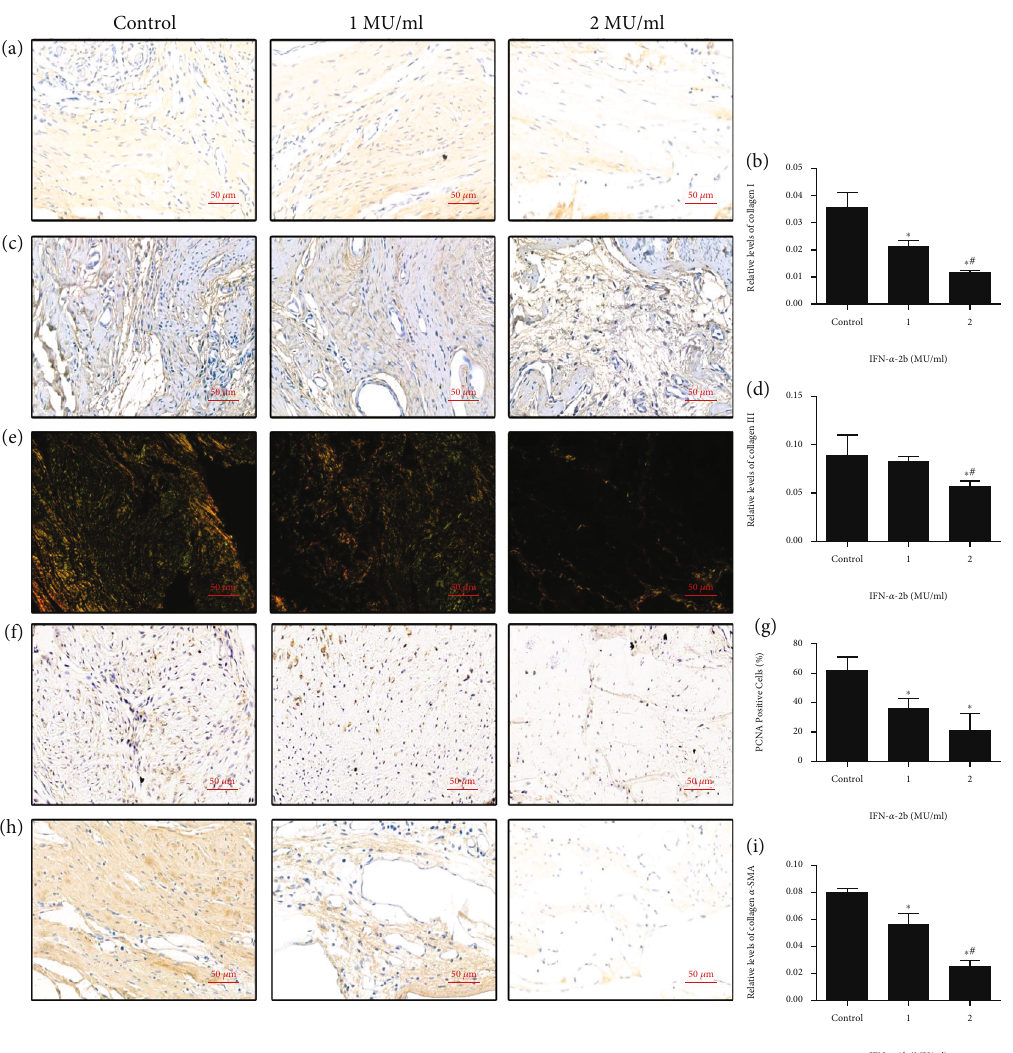
Figure 2: Immunohistochemical staining images of joint fi brosis in di ff erent groups ( × 400 magni fi cation). (a, c) The results of immunohistochemical staining of type I collagen and type III collagen in joint fi brotic tissue. (b, d) The positive expression of collagen immunohistochemical staining in the IFN- α -2b group was signi fi cantly reduced. IFN- α -2b e ff ectively inhibits the formation of collagen I and collagen III in fi brotic tissues. (e) The result of Sirius red staining was visualized by polarized light microscope, in which type I collagen was yellow and type III collagen was green. The image shows that collagen fi bers decrease with increasing drug concentration. (f, h) Immunohistochemical staining image of PCNA and α -SMA. (g, i) The IFN- α -2b medication group can signi fi cantly reduce the expression of PCNA and α -SMA. ∗ Compared with the control group. # Comparison between the two groups of IFN- α -2b medications, P < 0 : 05 ( n = 6